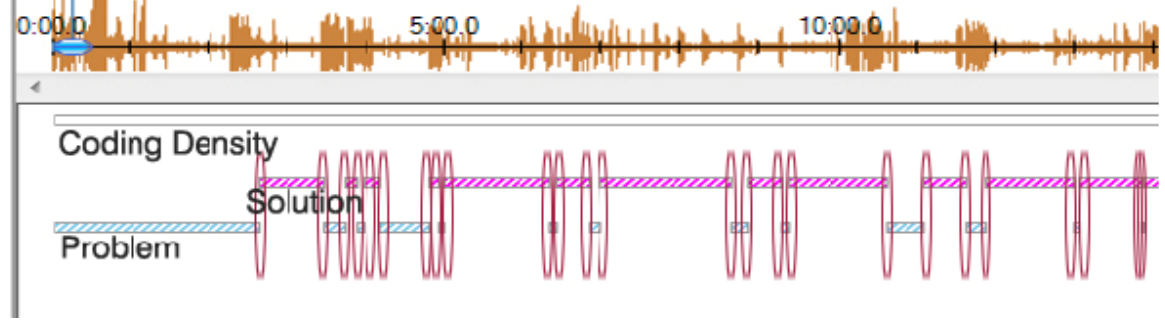
Figure 7. Co-evolution of the problem and solution